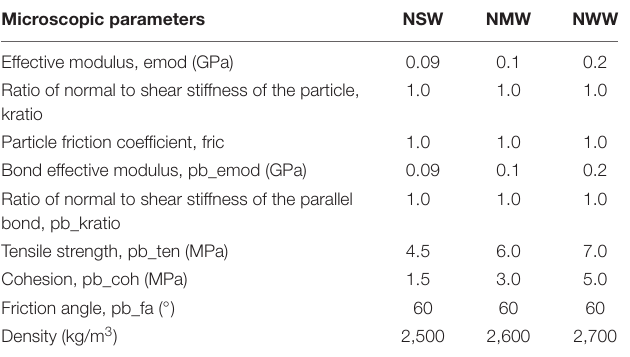
TABLE 3 | Microscopic parameters of three types of numerical diorite-porphyrite samples. Microscopic parameters